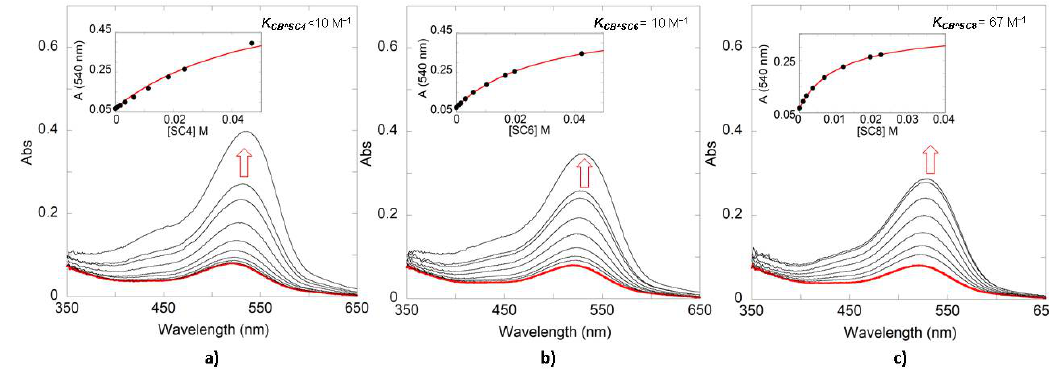
Figure 6. UV-Vis spectral variations of a Oenin upon addition of increasing concentrations of the SCn macrocycles. ( a ) Oenin 2 × 10 −5 M vs. SC4, pH = 3.52, ( b ) Oenin 1.8 × 10 −5 M vs. SC6, pH = 3.43 and ( c ) Oenin 1.8 × 10 −5 M vs. SC8, pH = 3.78. The inset shows the fitting for the calculation of the association constant considering a 1:1 H-G interaction using Equation (2). Table 2 . Association constants K CB^SCn (M −1 ) for the formation of 1:1 host-guest complexes between p -sulfonated calix[n]arenes and the CB^ species of Oenin. K CB^SCn (M −1 ) calculated after fitting (Eq. 2) of the data obtained after titration of Oenin (2.0 × 10 −5 M; 1.8 × 10 −5 M; 1.8 × 10 −5 M) solutions with increasing concentrations of SC4, SC6 and SC8 at pH ≈ 3.5.